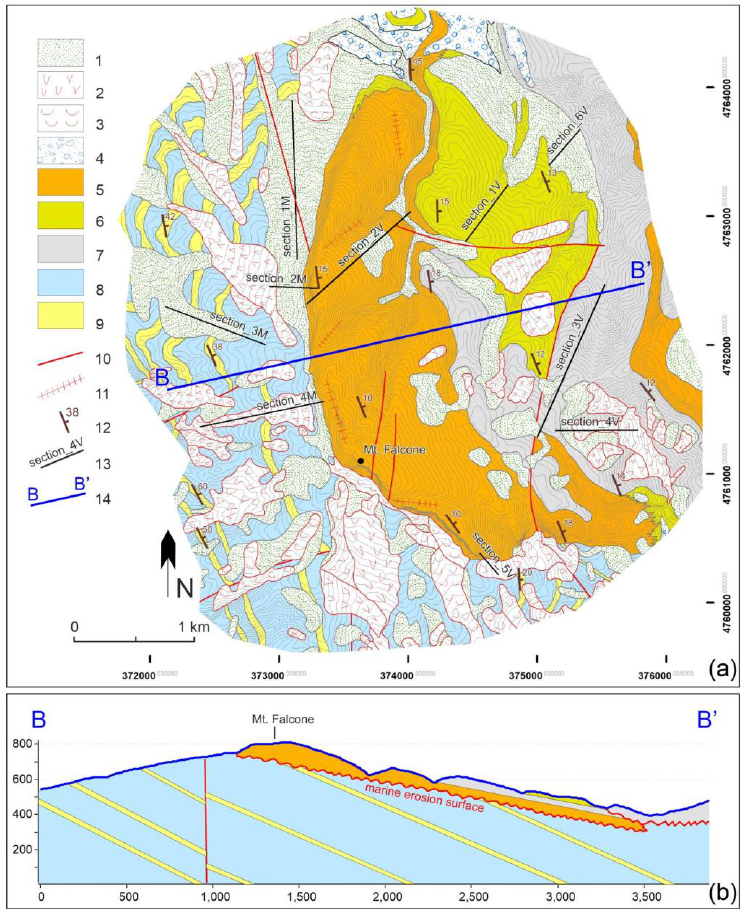
Figure 4 ( a ). Geological and geomorphological map of the study area: 1 — slope and colluvial depos- Figure 4. ( a ). Geological and geomorphological map of the study area: 1—slope and colluvial its (Holocene); 2 — rotational and planar slides (Holocene); 3 — flows (Holocene); 4 — old and recent deposits (Holocene); 2—rotational and planar slides (Holocene); 3—flows (Holocene); 4—old and fluvial deposits (Pleistocene – Holocene); 5 — arenaceous-conglomeratic bedrock (Mount Falcone body — Middle Pliocene); 6 — mainly arenaceous-pelitic bedrock (Argille Azzure Formation — Mid- recent fluvial deposits (Pleistocene–Holocene); 5—arenaceous-conglomeratic bedrock (Mount Falcone dle Pliocene); 7 — mainly clayey bedrock (Argille Azzure Formation — Middle Pliocene); 8 — mainly body—Middle Pliocene); 6—mainly arenaceous-pelitic bedrock (Argille Azzure Formation—Middle pelitic-arenaceous bedrock (Laga formation — Late Messinian); 9 — mainly arenaceous-pelitic bed- Pliocene); 7—mainly clayey bedrock (Argille Azzure Formation—Middle Pliocene); 8—mainly rock (Laga formation — Late Messinian); 10 — main faults; 11 — gravitational trench; 12 — strata atti- tude; 13 — trace of cross-section used for the numerical simulation; 14 — trace of geological cross- pelitic-arenaceous bedrock (Laga formation—Late Messinian); 9—mainly arenaceous-pelitic bedrock section described in ( b ). (Laga formation—Late Messinian); 10—main faults; 11—gravitational trench; 12—strata attitude; 13—trace of cross-section used for the numerical simulation; 14—trace of geological cross-section described in ( b